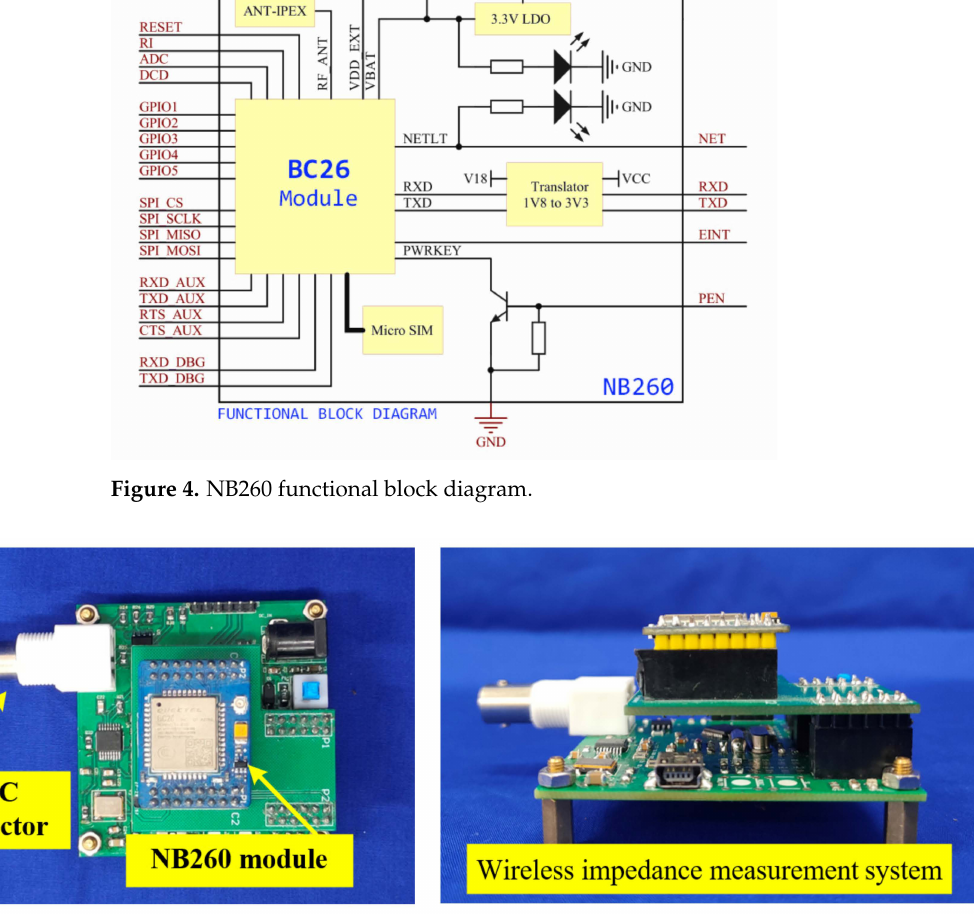
Figure 5. Photos of wireless impedance measurement